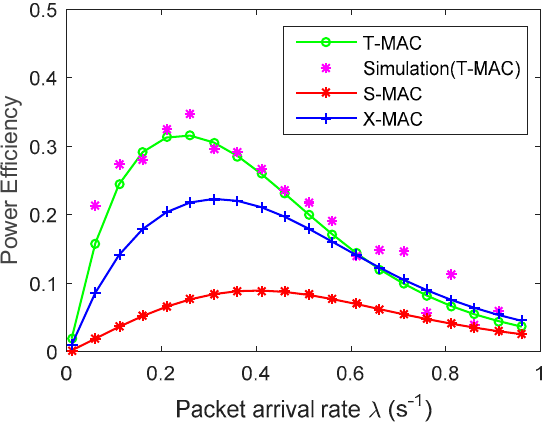
Figure 8. The power efficiency for T-MAC, S-MAC and X-MAC protocols versus packet arrival rate.